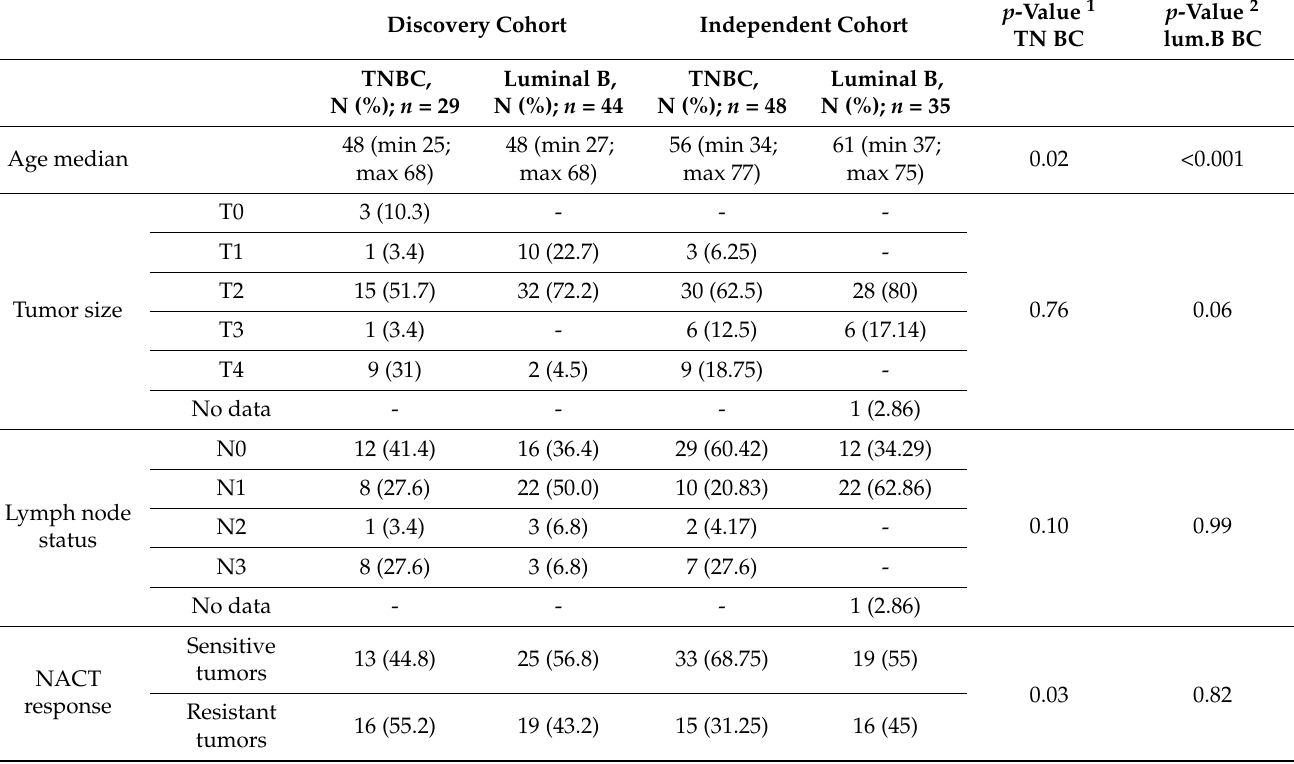
Table 1. Clinical and pathological characteristics of discovery cohort patients ( n = 73) and independent cohort patients ( n = 83). p -value shows statistical differences in clinical features between cohorts. Discovery